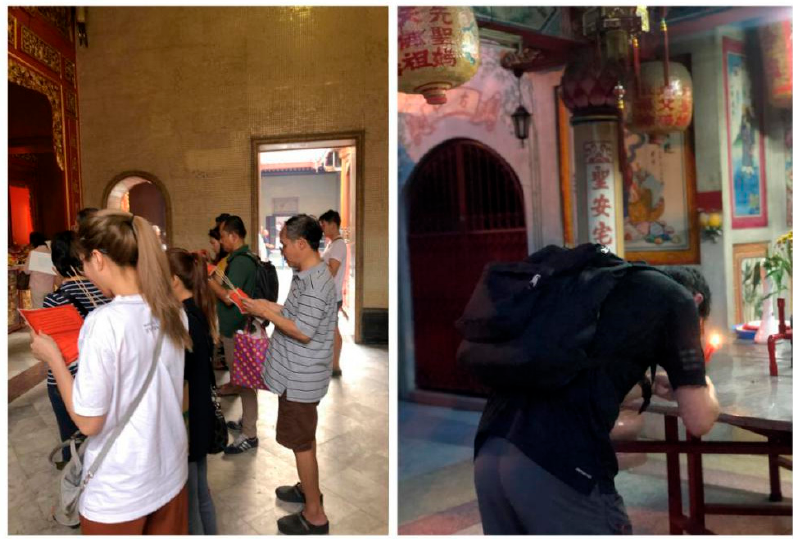
Figure 5. Tourists participate in religious activities.